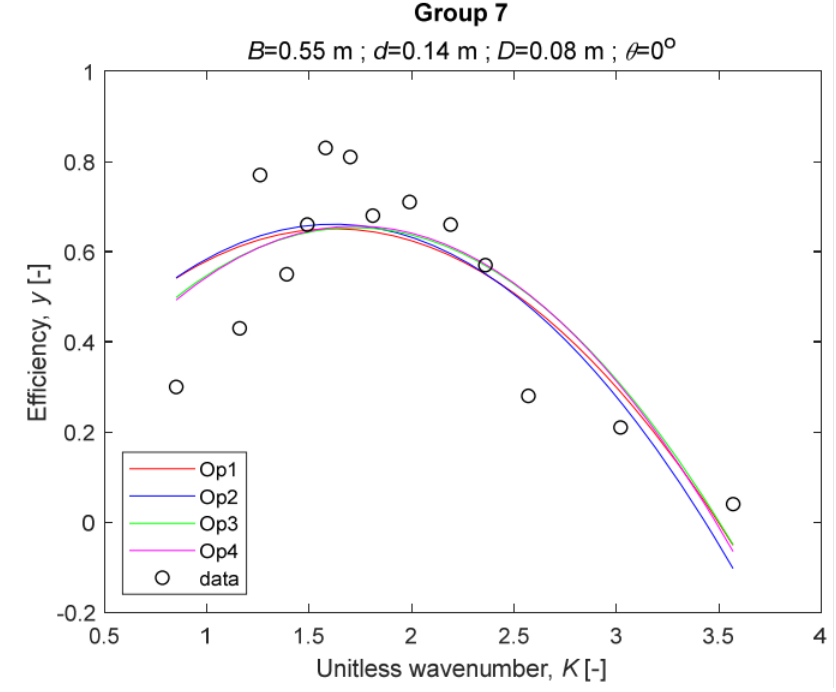
Figure 9. The four models for Group 7.